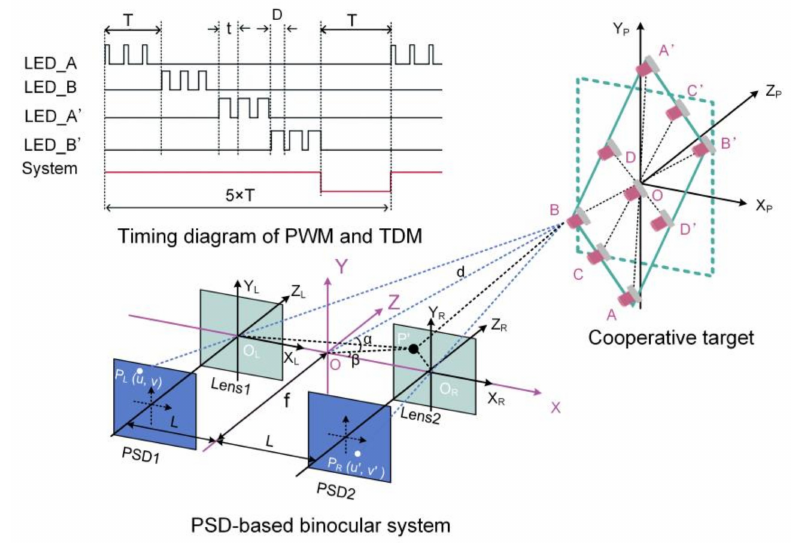
Figure 6. 6-DOF full posture measurement using the cooperative